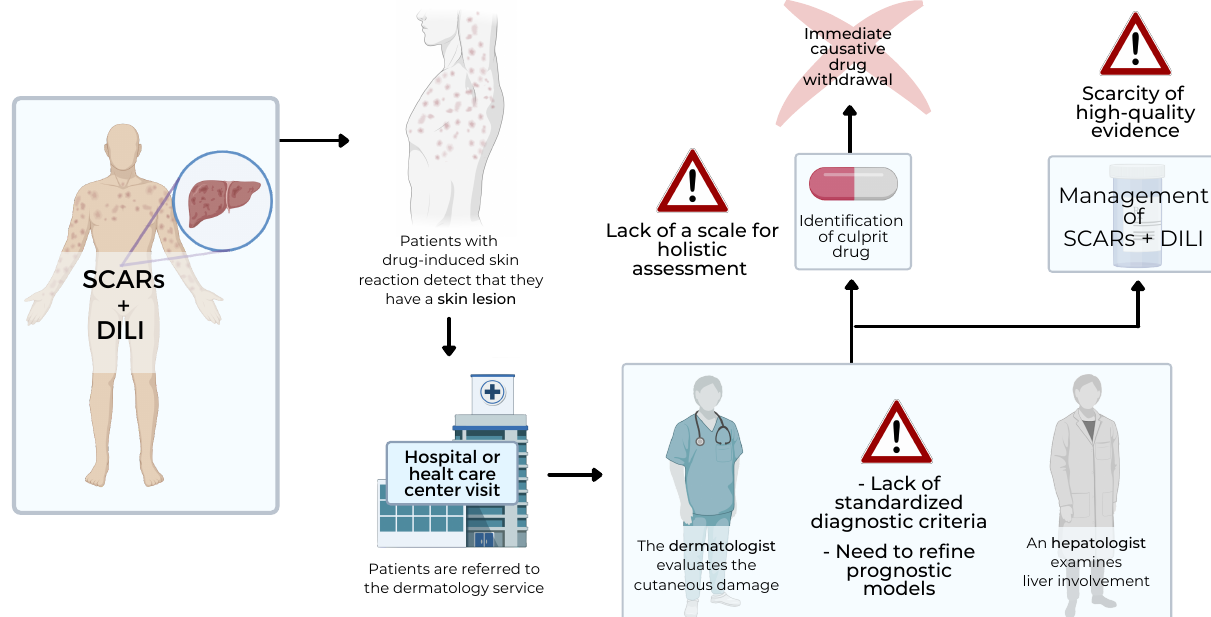
Figure 3. Identified gaps in the pathway of diagnosis and management of DILI associated with SCARS. DILI, Drug-Induced Liver Injury; SCAR, Severe Adverse Cutaneous